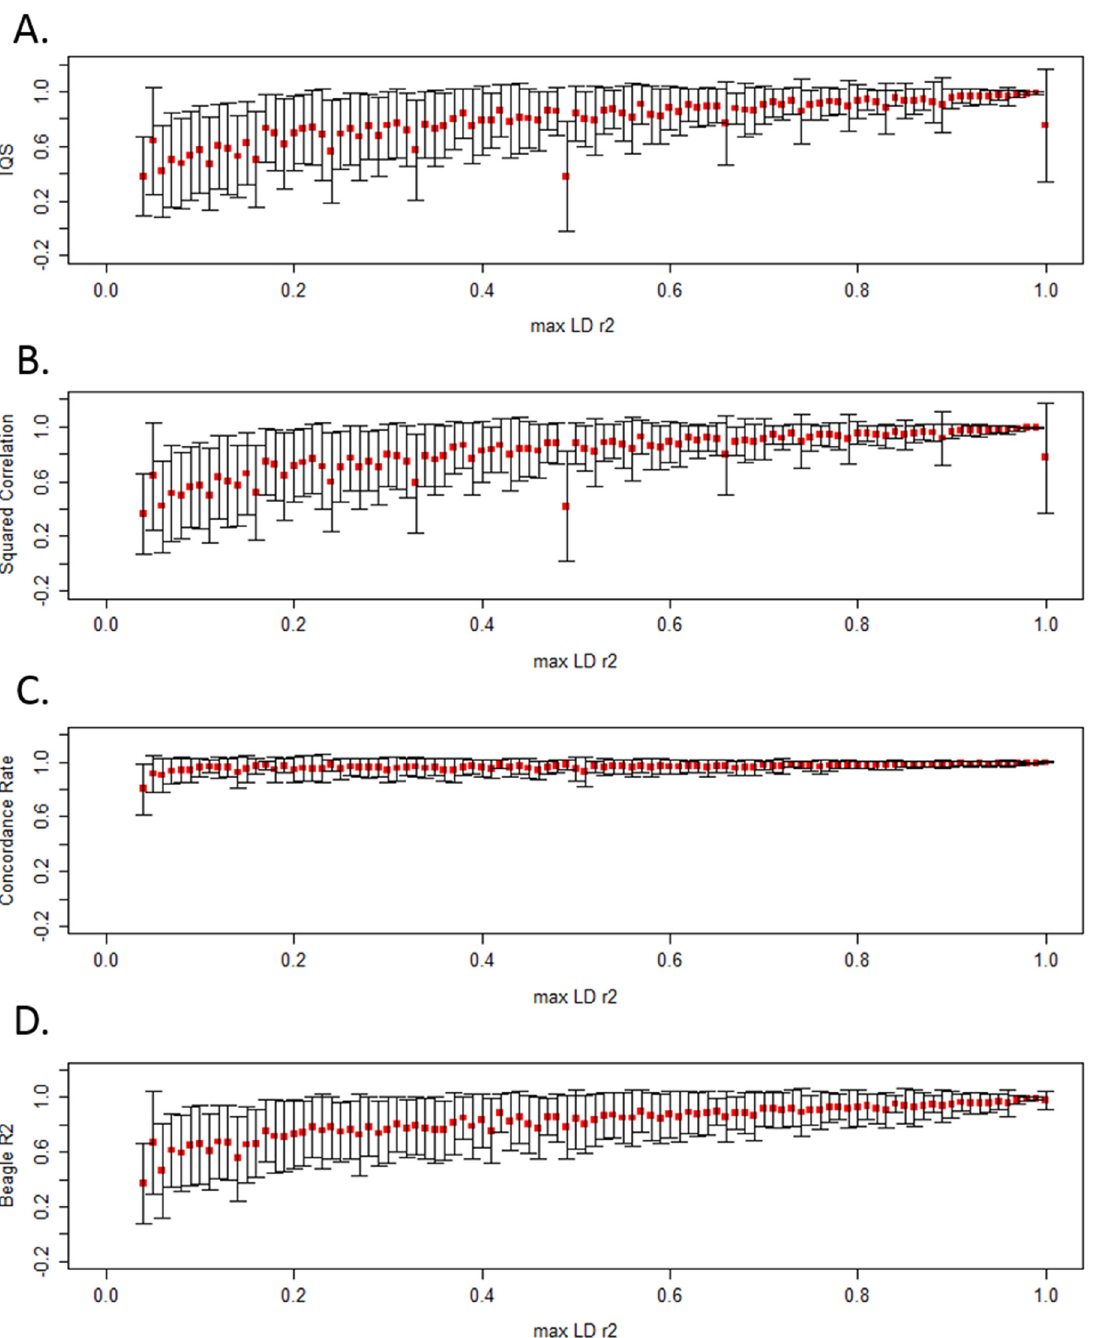
Fig 3. IQS, squared correlation, concordance rate, and BEAGLE R 2 are shown in max r 2 LD bins. Mean accuracy of SNPs in each MAF bin (defined by 0.01 increments with N = 13,442 variants total) is denoted by the red dots and the bars indicate one standard deviation (above and below the mean). These results were produced by using the 1000 Genomes AFR reference population as the study sample with Omni 2.5M typed coverage on chromosome 15.